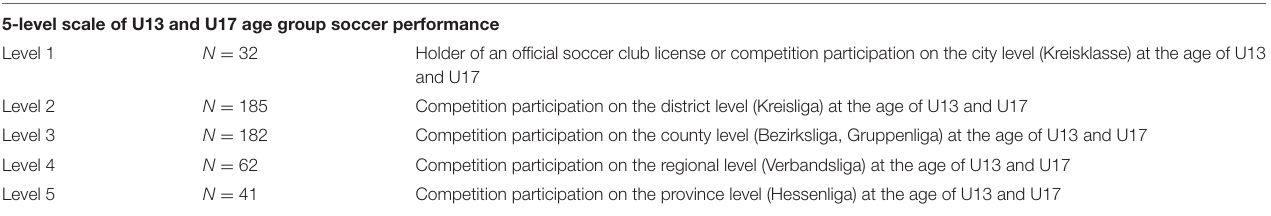
TABLE 1 | Five-level scale for the recording of the soccer-specific competition results of the study participants taking part in official soccer competitions of the age groups U13 and U17 ( N = 502). 5-level scale of U13 and U17 age group soccer